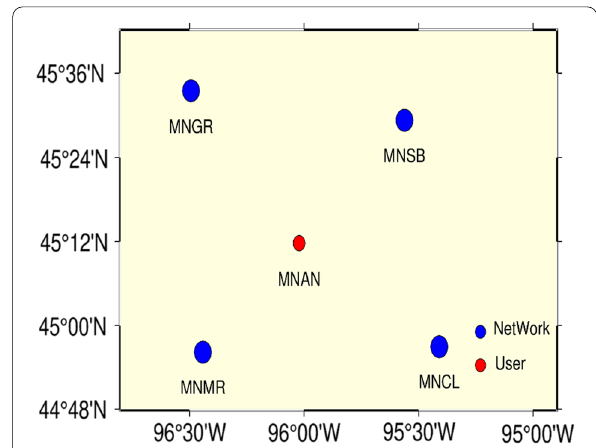
Fig. 9 Distribution of the GPS/Galileo stations from days 082 to 083 in 2021. The blue circles indicate the reference stations and the red circle denotes the user station